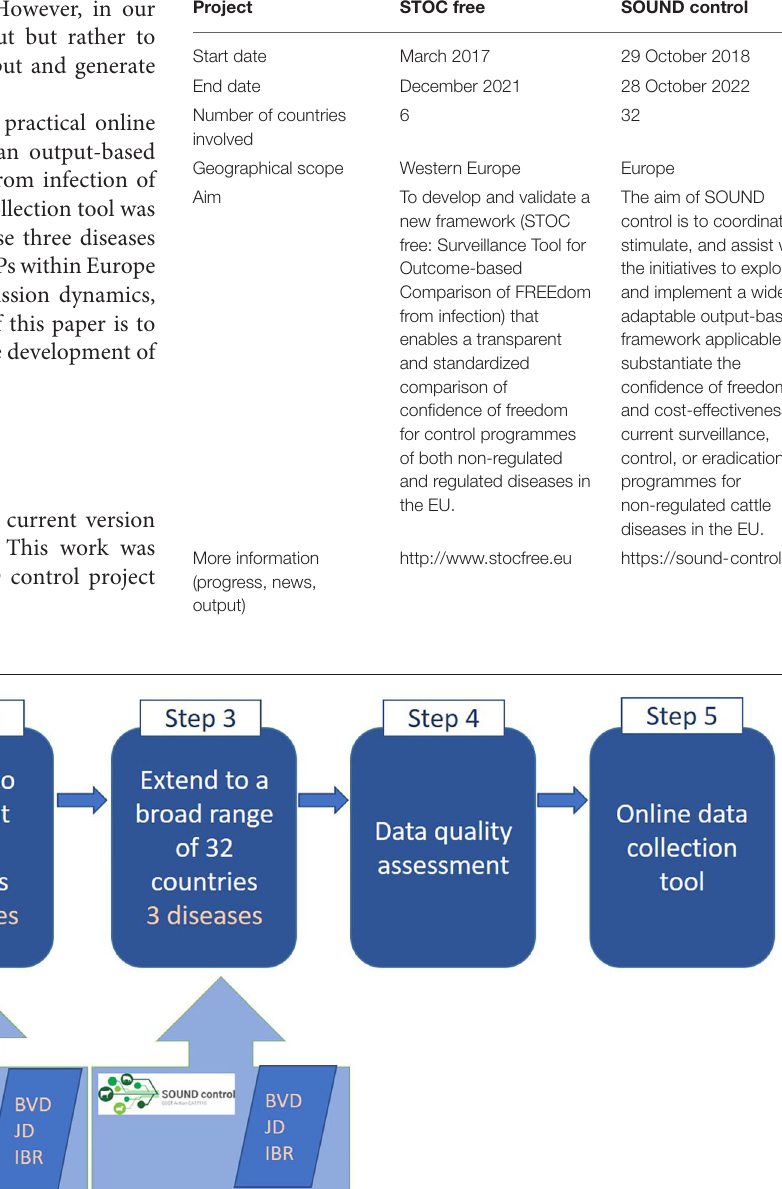
Frontiers in Veterinary Science |